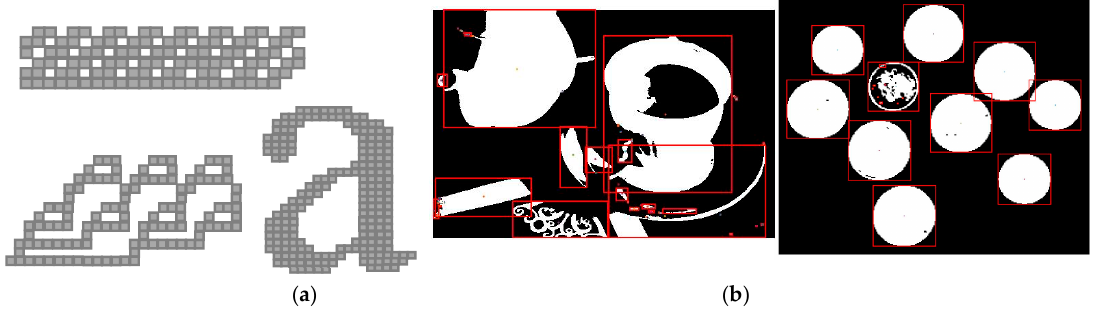
Figure 8. Sample images used to extract: ( a ) area features, ( b ) bounding boxes, and centroids.